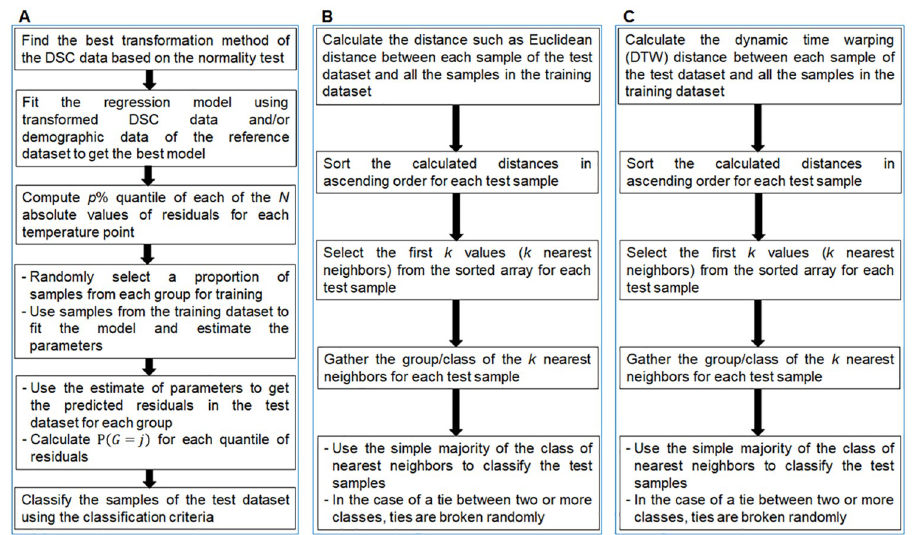
Fig 2. Overview of the classification methods. (A) Parametric method, (B) K-nearest neighbors method and (C) Dynamic time warping- K-nearest neighbors